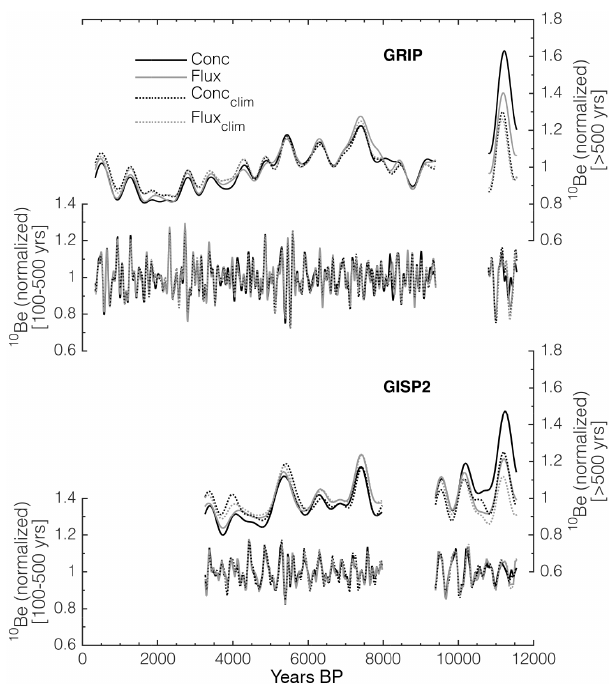
Figure 2. Comparison of 10 Be fluxes and concentrations over the Holocene. Solid black and grey curves denote 10 Be concentrations and fluxes, respectively. Dotted lines refer to the “climate corrected” (see text) versions of concentrations and fluxes with similar colour coding as solid lines. The top two panels show GRIP 10 Be for varia- tions on timescales longer (top) than 500 years, and for wavelengths between 100 and 500 years (below). The 100-year cut-off has been applied for clarity of the figure. The bottom two panels show GISP2 10 Be for the same wavelengths as for